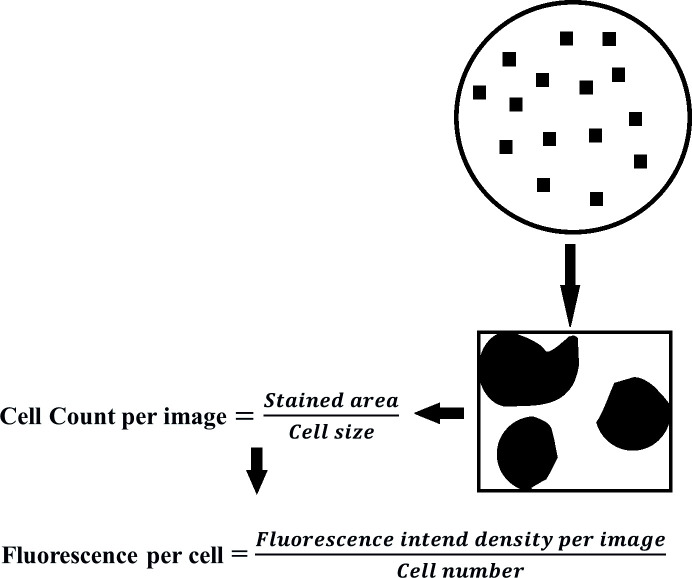
Calculation procedure followed to determine fluorescent intensity from fluorescent image obtained in cell analyzer.